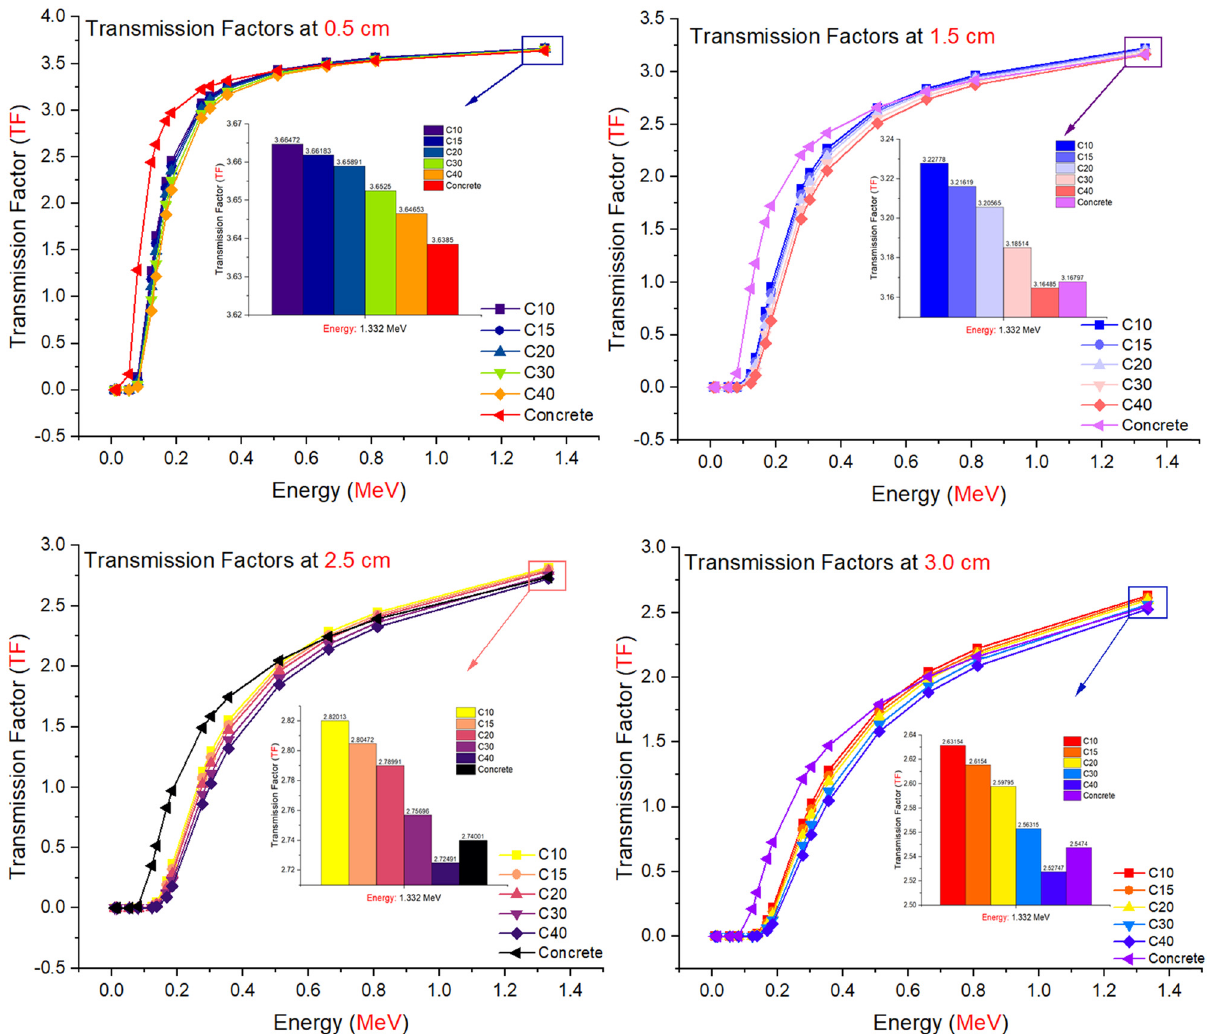
Figure 4: Comparison of the TFs as a function of used radioisotope energy ( MeV ) for di ff erent glass thicknesses and